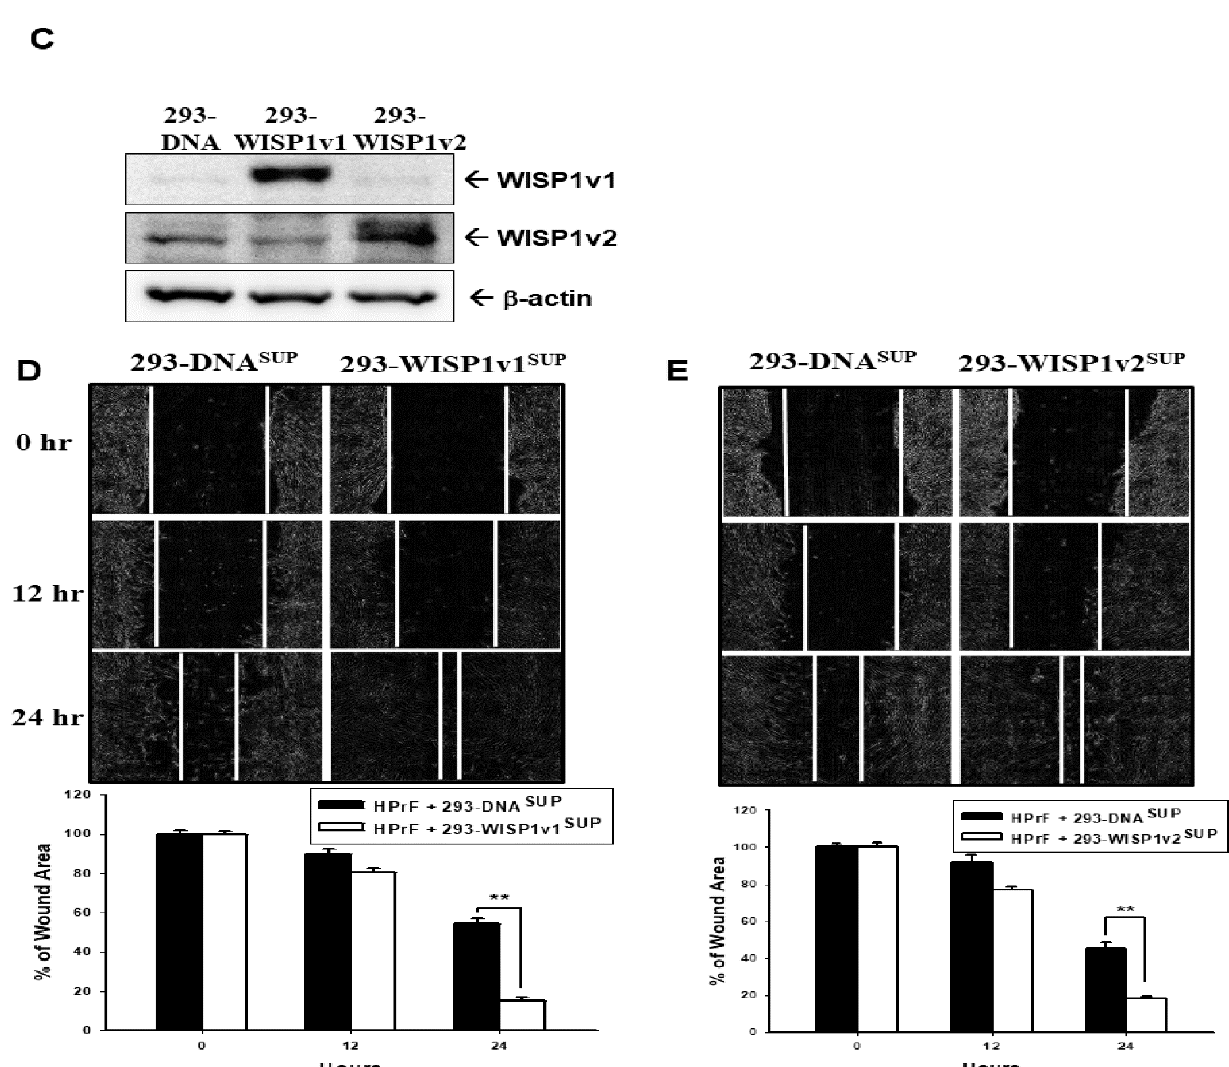
Figure 2. Modulating effect of the conditioned media from the ectopic WISP1 overexpressed-HEK 293 cells on the cell migration in the prostate fibroblast HPrF cells. ( A ) Expressions of WISP1v1 and WISP1v2 after the ectopic-overexpressed WISP1v1 and WISP1v2 in the HEK293 cells were assessed by the RT-PCR (M: 100 bp Marker; 1: HPrF_shCOL; 2: HPrF_shWISP1), ELISA ( B ), and immunoblot ( C ) assays. The abilities of migration in HPrF cells treated with the conditioned media of the ectopic WISP1v1- ( D ) or WISP1v2- ( E ) overexpressed-HEK293 cells. The white line indicated the average of the cellular leading edges and the size of the wound area was calculated by ImageJ. Data are presented as the mean percentage ( ± SE; n = 3) in relation to the mock-transfected HEK293 (293-DNA) cells. ** p < 0.01; ND: no